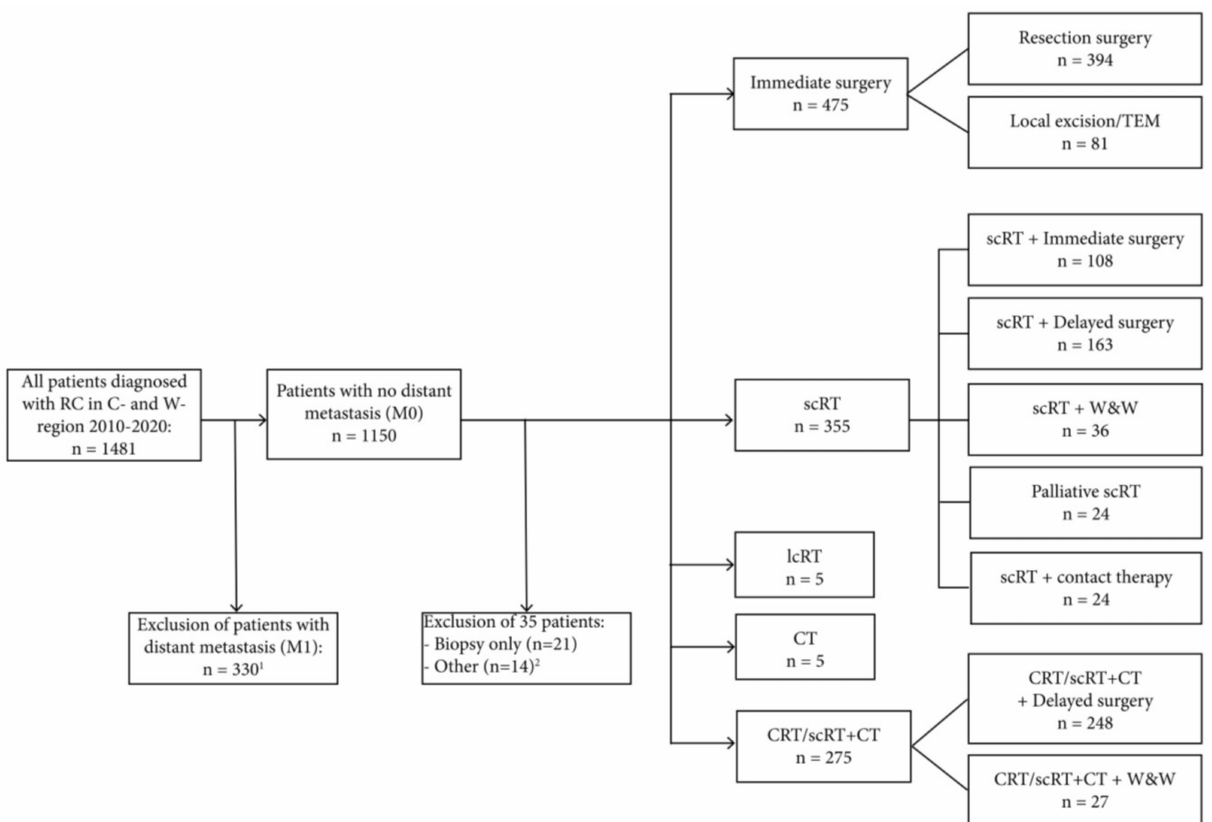
Figure 1. Flow chart of patient selection. 1 One patient had a missing cTNM status and was excluded. 2 Patients that were too ill to be treated ( n = 4), died before initiating treatment ( n = 2), carcinoma in situ ( n = 2), another metastatic tumour type simultaneously ( n = 2), sigmoidal cancer ( n = 1),